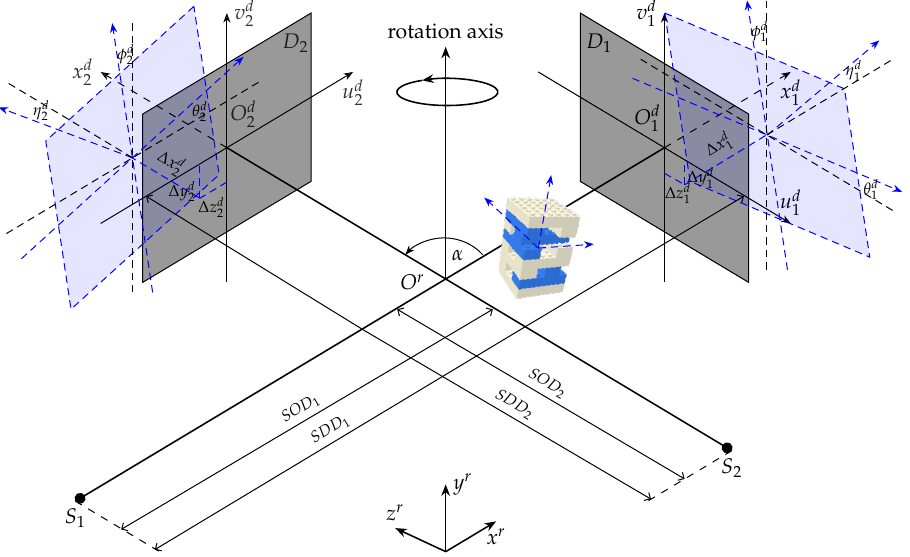
Figure 2. A stereo cone-beam geometry of an X-ray CT